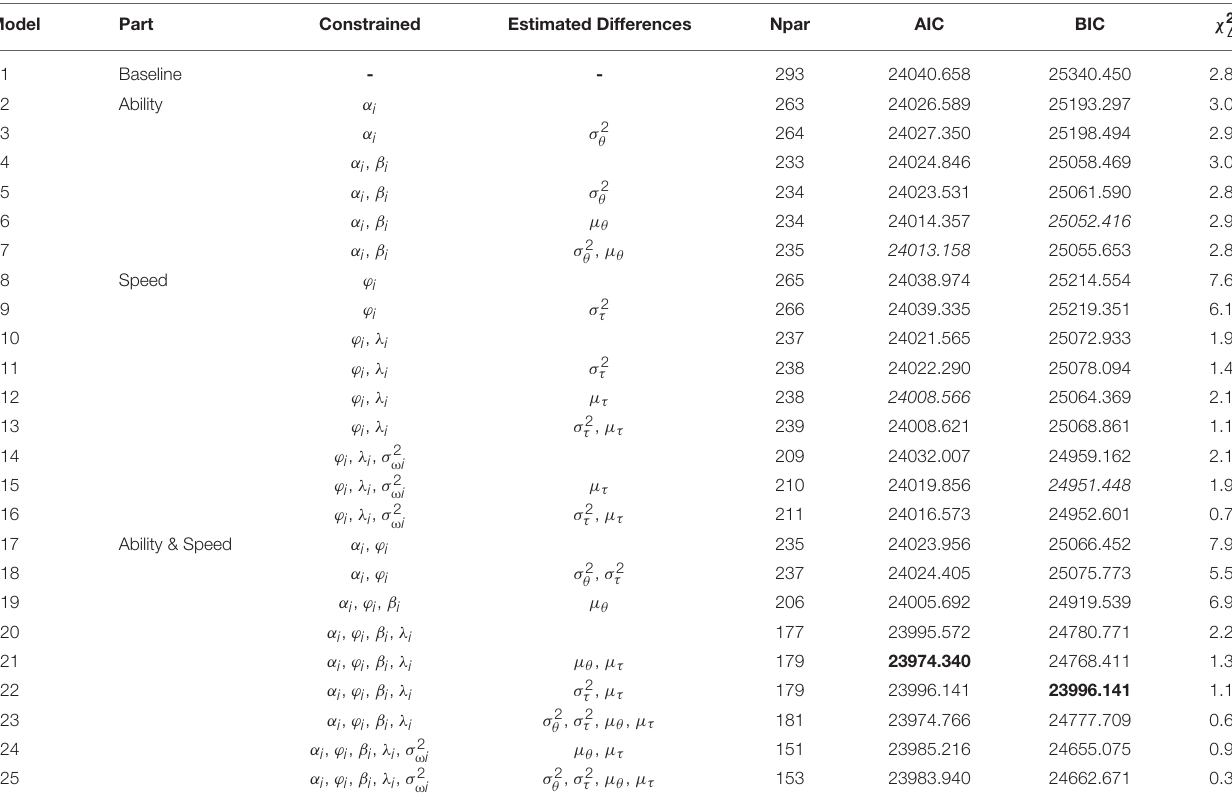
TABLE 4 | Measurement invariance of the B-GLIRT model with linear interaction term in the cross-relation function with respect to gender for data from paper-based assessment.